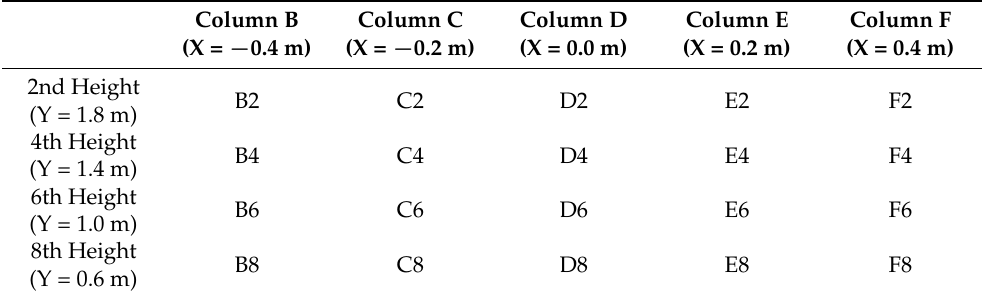
Table 1. Locations of wind velocity measurement